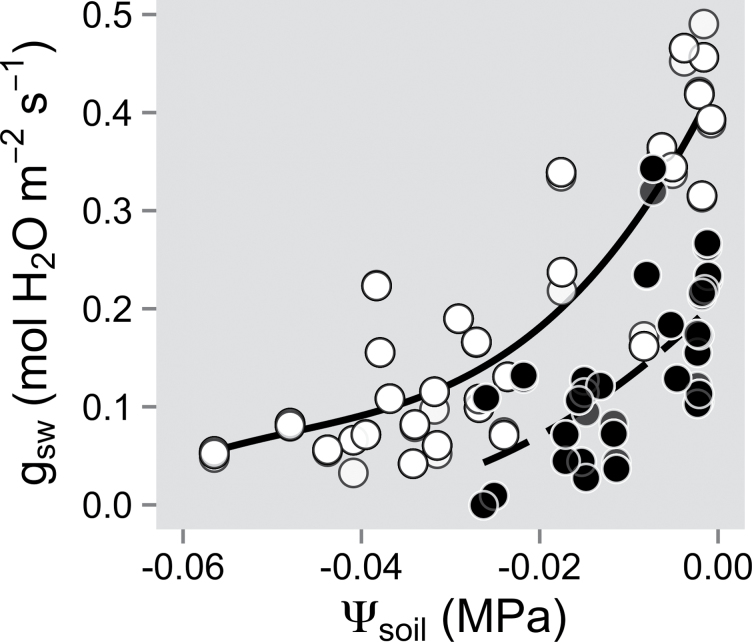
Responses of stomatal conductance (g
sw) to decreasing soil water potential (Ψsoil) during the short-term drought experiment. A second-order polynomial curve was fitted for each clone [Assiniboine (open circles), R
2=0.79; and Okanese (filled circles), R
2=0.39; P < 0.0001].